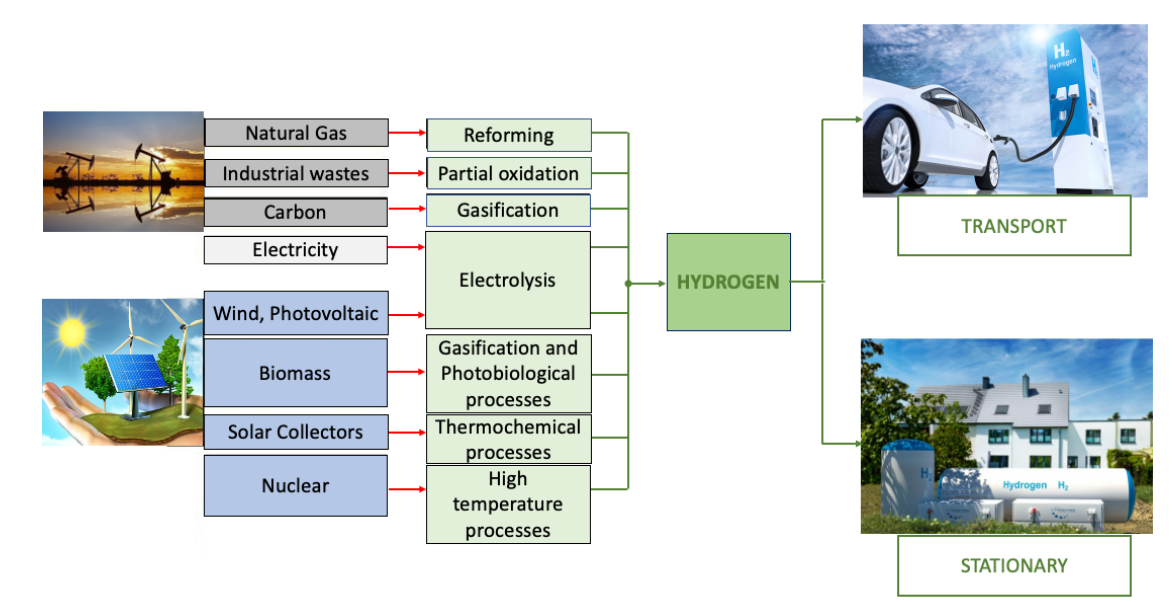
Figure 3. Main methods for hydrogen production.